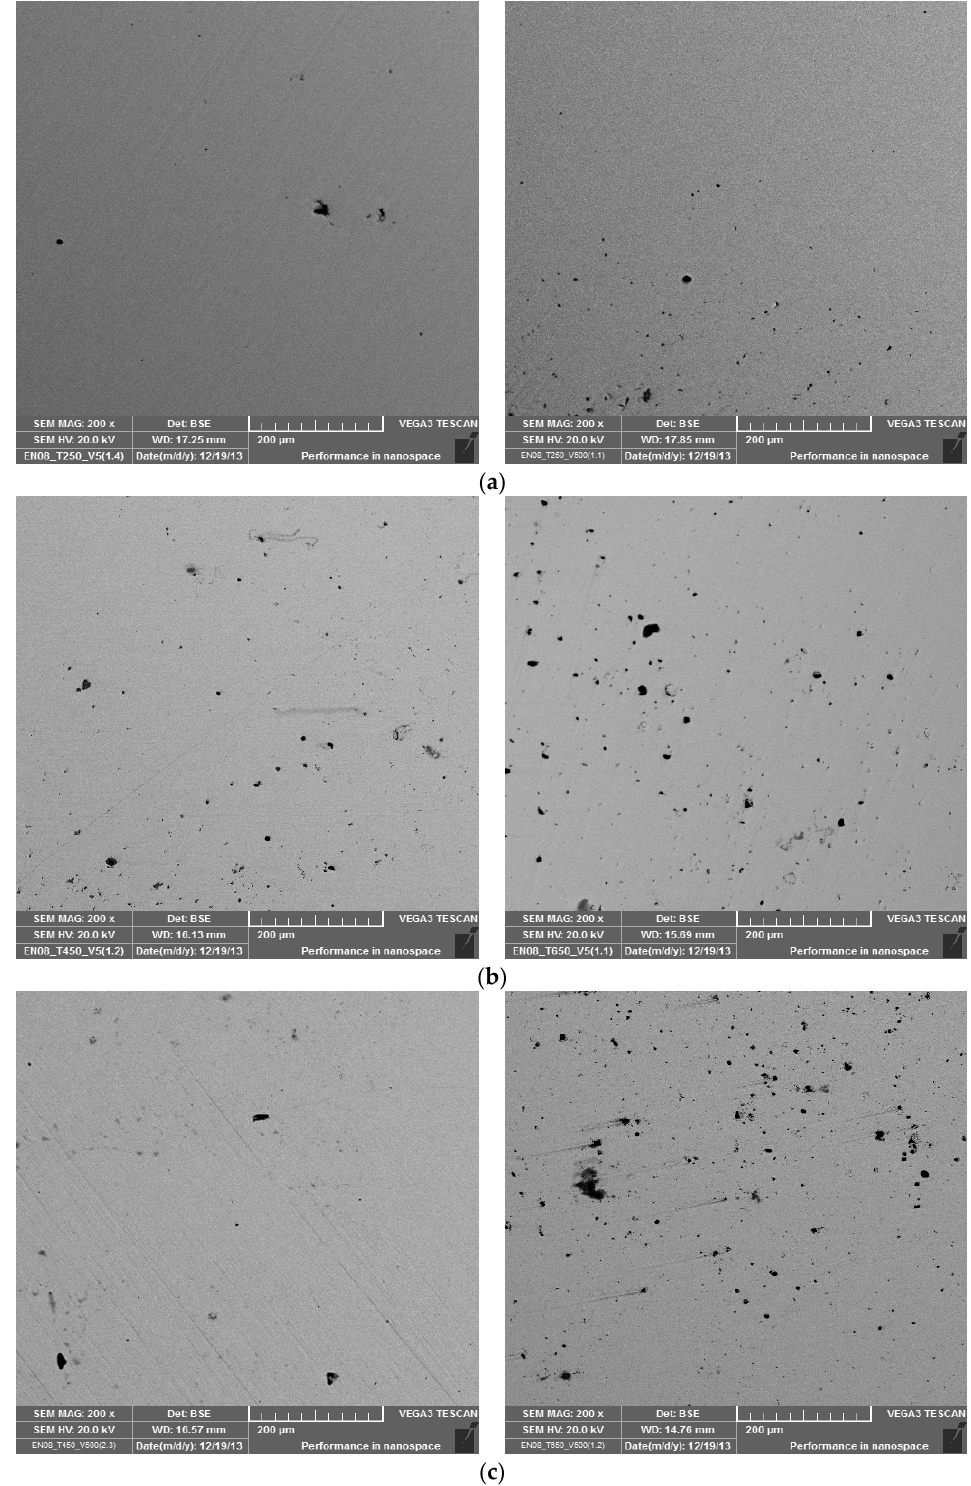
Figure 7. SEM images for polished samples at a temperature of ( a ) 523 K, ( b ) 723 K, ( c ) 923 K, and at strain rates of 0.0015 s − 1 ( left ) and 0.15 s − 1 ( right ).